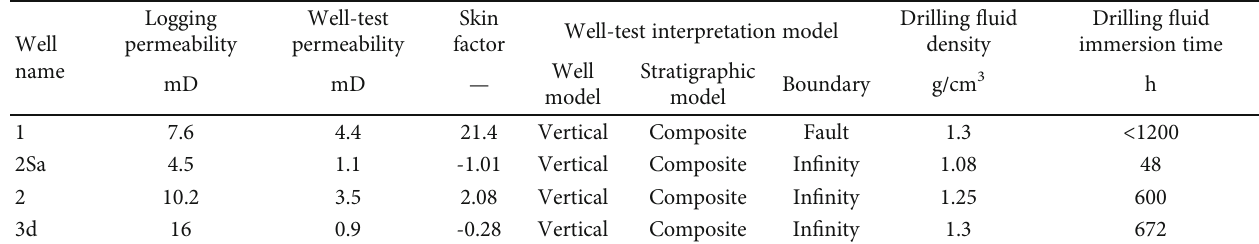
Table 3: Well-test interpretation statistics for o ff shore low-permeability wells.